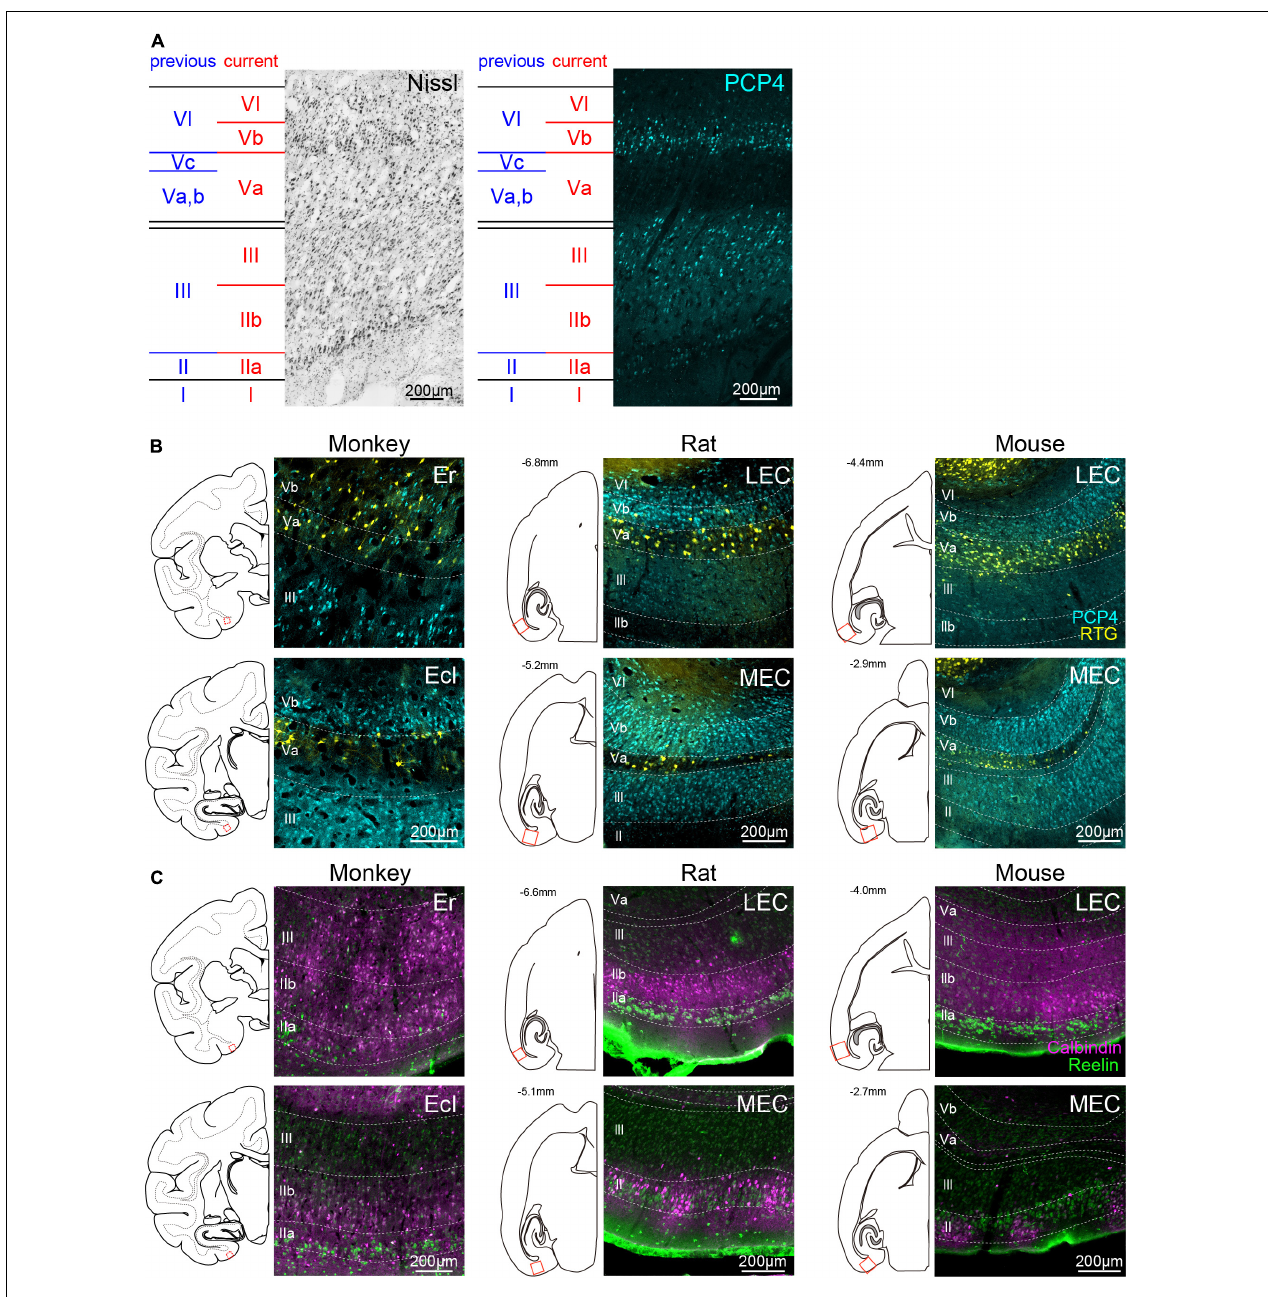
FIGURE 1 | Laminar definition of monkey EC and inter-species comparison of laminar markers. (A) Representative Nissl- and PCP4-stained images taken from caudal division of monkey EC (Ec). Previous laminar definition in monkey EC (blue; Amaral et al., 1987), which is based on cytoarchitectonic features, is compared with the definition used in the current study (red). The current definition is based on the distribution of PCP4-labeled neurons (cyan) in addition to the distribution of Nissl-stained cells, and confirmed by connectional data. (B) Distribution of PCP4 + neurons (cyan) and NAc-projecting neurons (yellow) in monkeys (left), rats (middle), and mice (right). Fluorescent images were taken from monkey Er (top-left) and Ecl (bottom-left) in coronal sections, and rodent LEC (top-middle, top-right) and MEC (bottom-middle, bottom-right) in horizontal sections corresponding to the boxed areas in the line drawings. For visual purpose, the images of monkey EC are horizontally flipped. (C) Distribution of CB + neurons (magenta) and RE + neurons (green) in the EC of monkeys and rodents. The organization of the panels are the same as (B) .